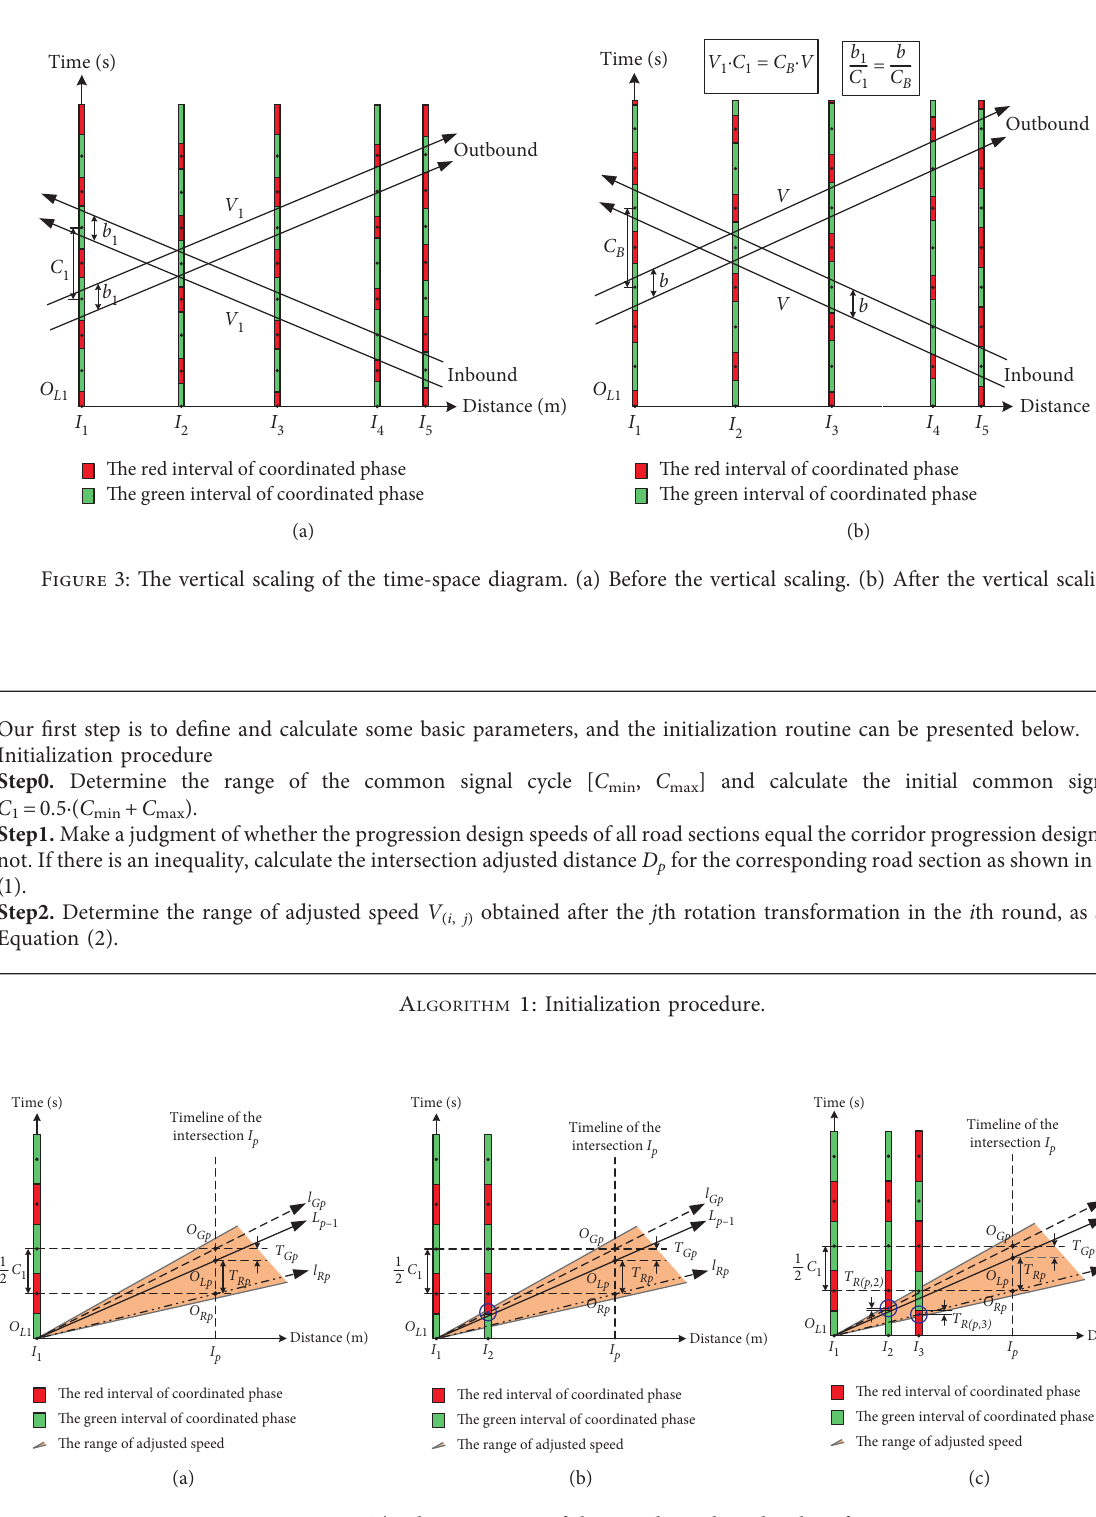
Figure 4: The determination of the coordinated mode when f